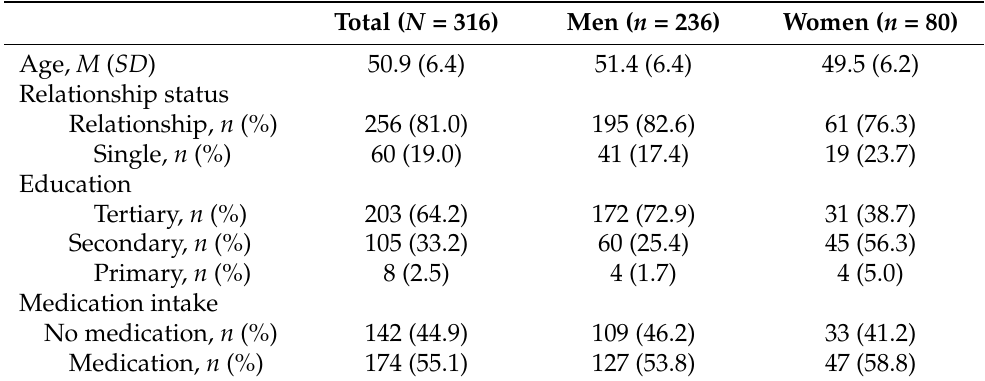
Table 1. Participants’ sociodemographic